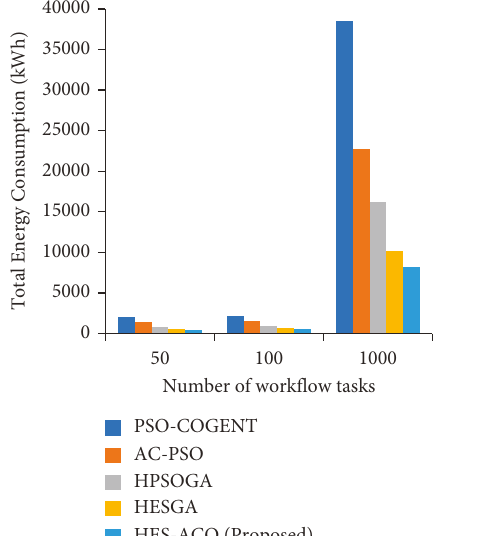
Figure 8: Makespan